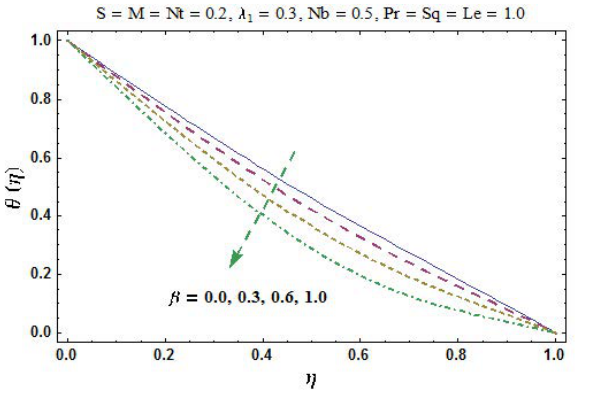
Figure 3. Plots of θ ( η ) for β .